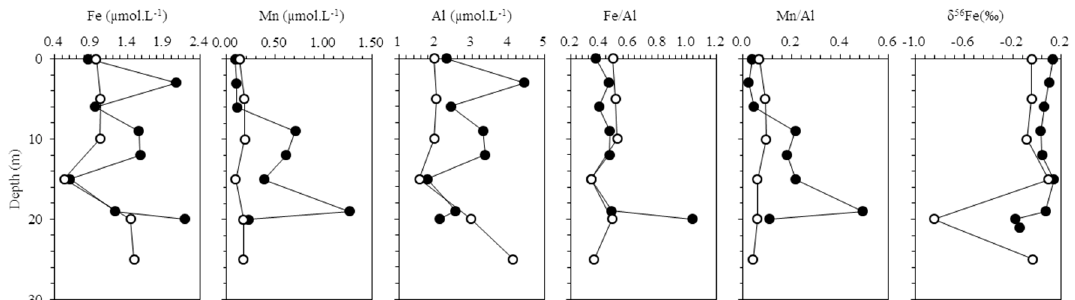
Figure 3. Depth profiles of Fe, Mn, and Al; Fe/Al and Mn/Al ratios; and δ 56 Fe values of suspended particulate matter in summer and winter in Hongfeng Lake.